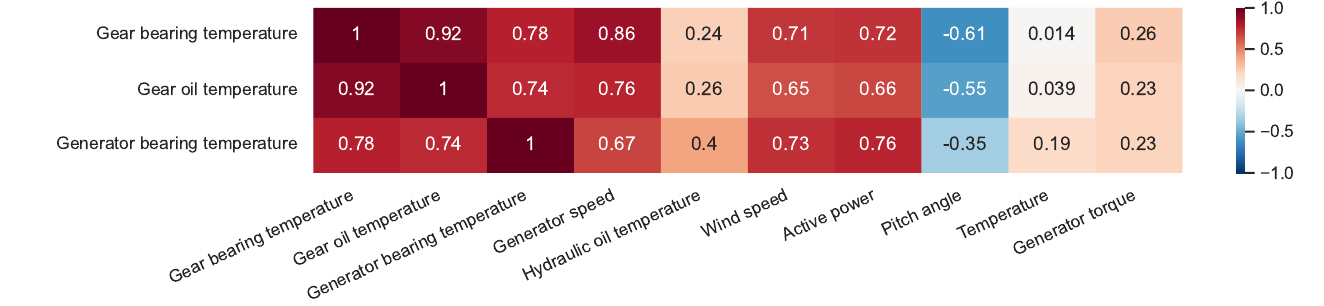
Figure 3. Pearson correlation coefficient between the output and input variables. For each one of the target variables, we use a deep learning algorithm to model their expected behavior. The typically used deep learning models can be divided into three typical architectures: the feed-forward neural network (FFNN), the recurrent neural network (RNN), and a convolutional neural network (CNN). This paper uses a CNN